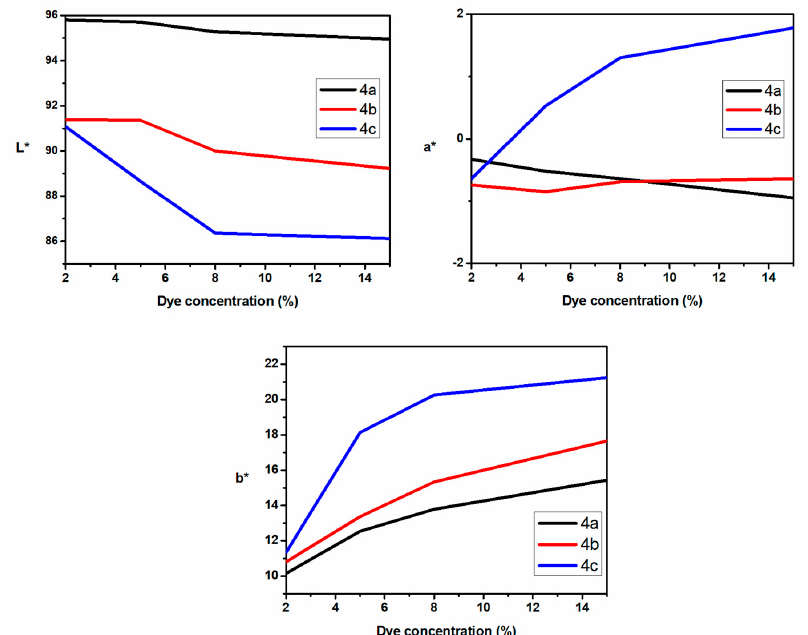
Figure 3. The dependence of CIEL*a*b* parameters on the dye concentration for dyes 4a , 4b , and 4c